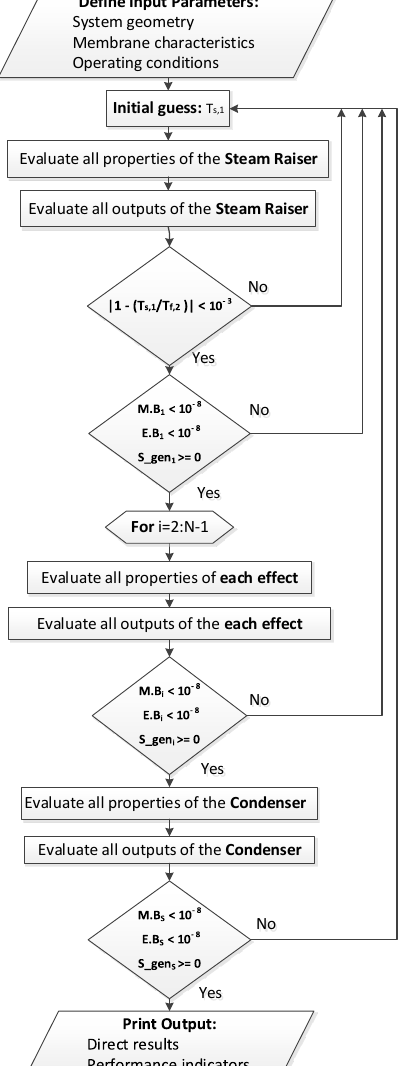
Figure 5. Solution Figure 5. Solution algorithm.